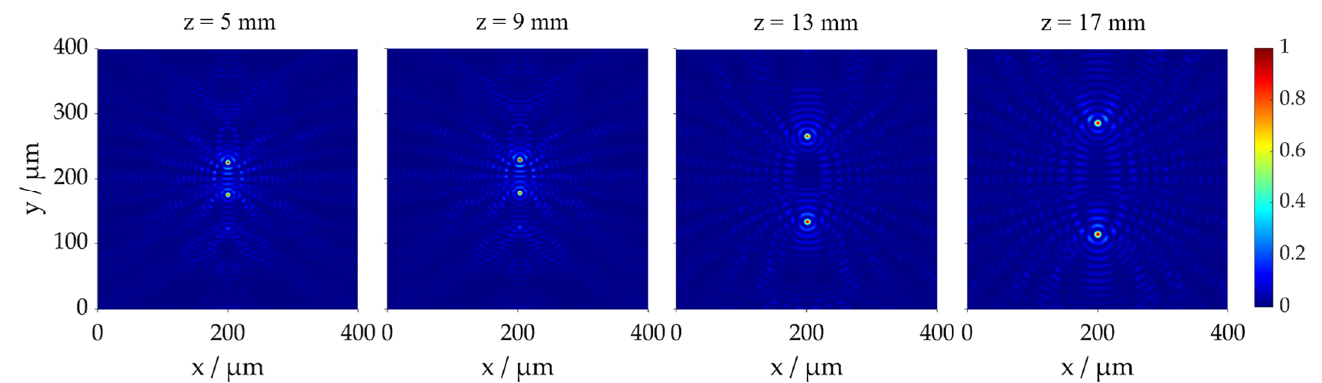
Figure 4. Simulated lateral intensity distributions of the multi-Bessel beam in the focal plane after lens 3 is taken in different z-axis positions from 5 mm to 17 mm in 4 mm steps.